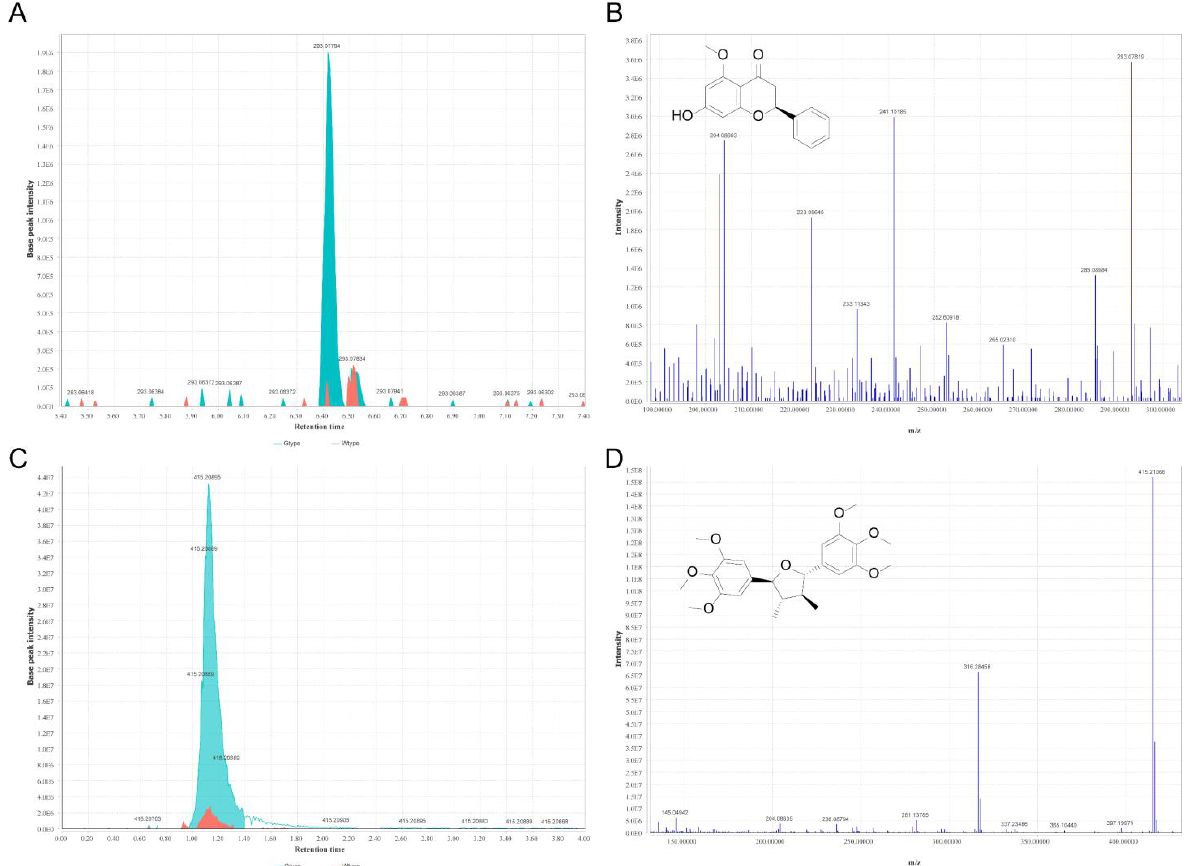
Figure 8. The representative extract ion chromatograms of alpinetin (m/z 293.07944) of the two types of P. sibiricum acquired in positive ionization mode ( A ) and its MS2 spectra ( B ). The representative extract ion chromatograms of grandisin (m/z 415.21112) of the two types of P. sibiricum acquired in positive ionization mode ( C ) and its MS2 spectra ( D ).